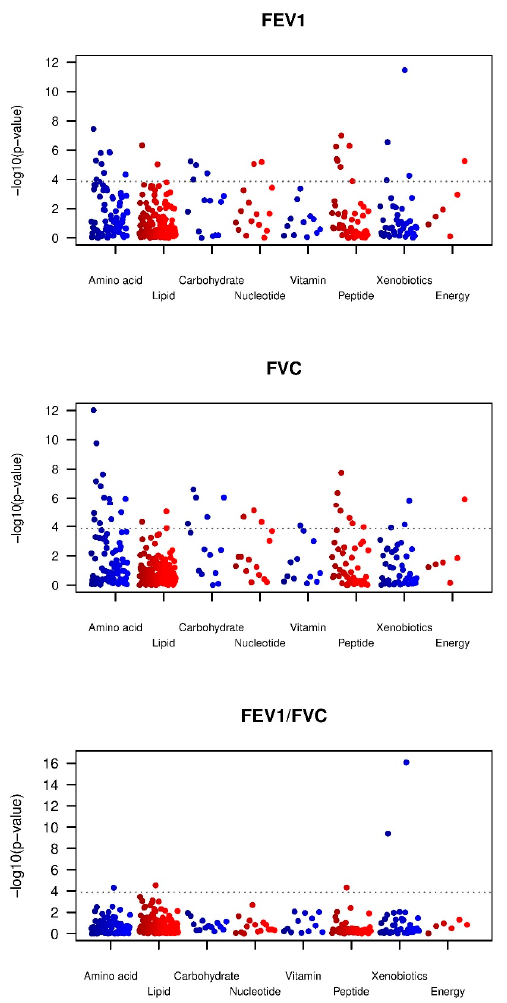
Figure 1. Manhattan plots for metabolome-wide association p-values for the three pulmonary function parameters in meta-analysis. The X axis indicates metabolite classes (super pathways) and Y axis indicates –log(10) p-values for each metabolites.